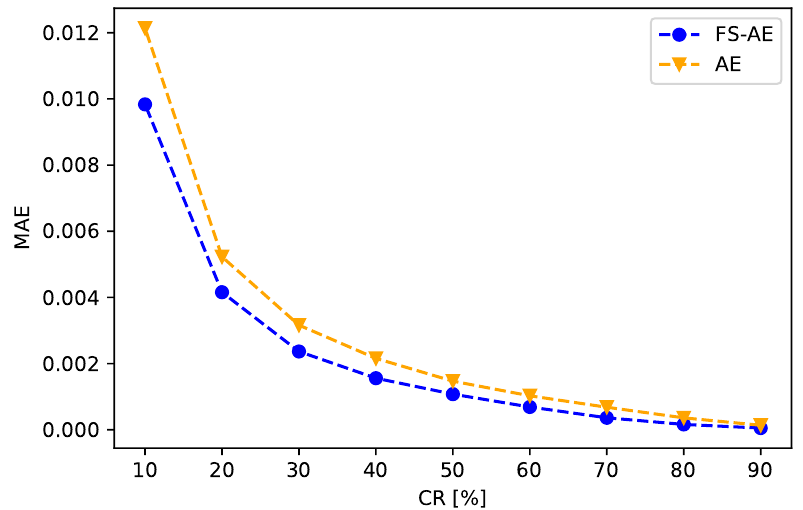
Figure 12. Reconstruction errors (MAEs) of the existing and proposed methods in decoding the spatial